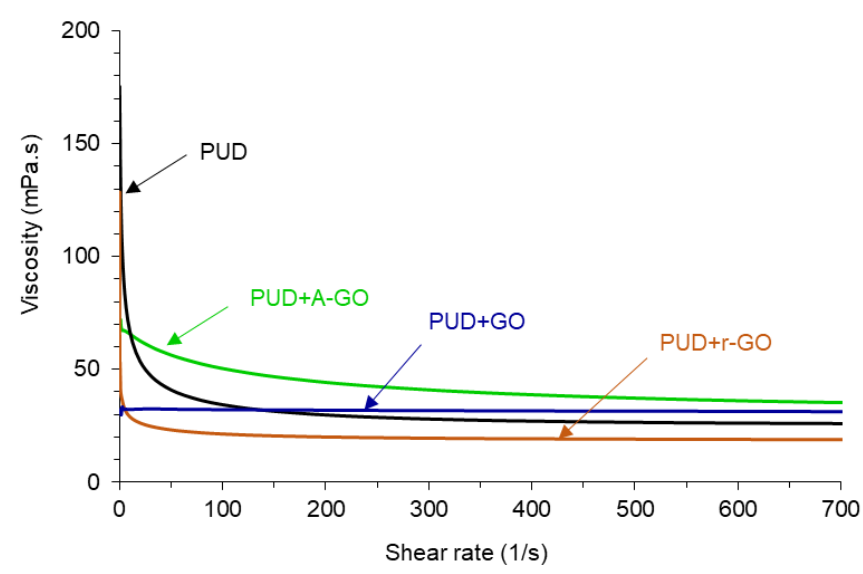
Figure 8. Variation of the viscosity at 25 °C of the PUDs as a function of the shear rate.